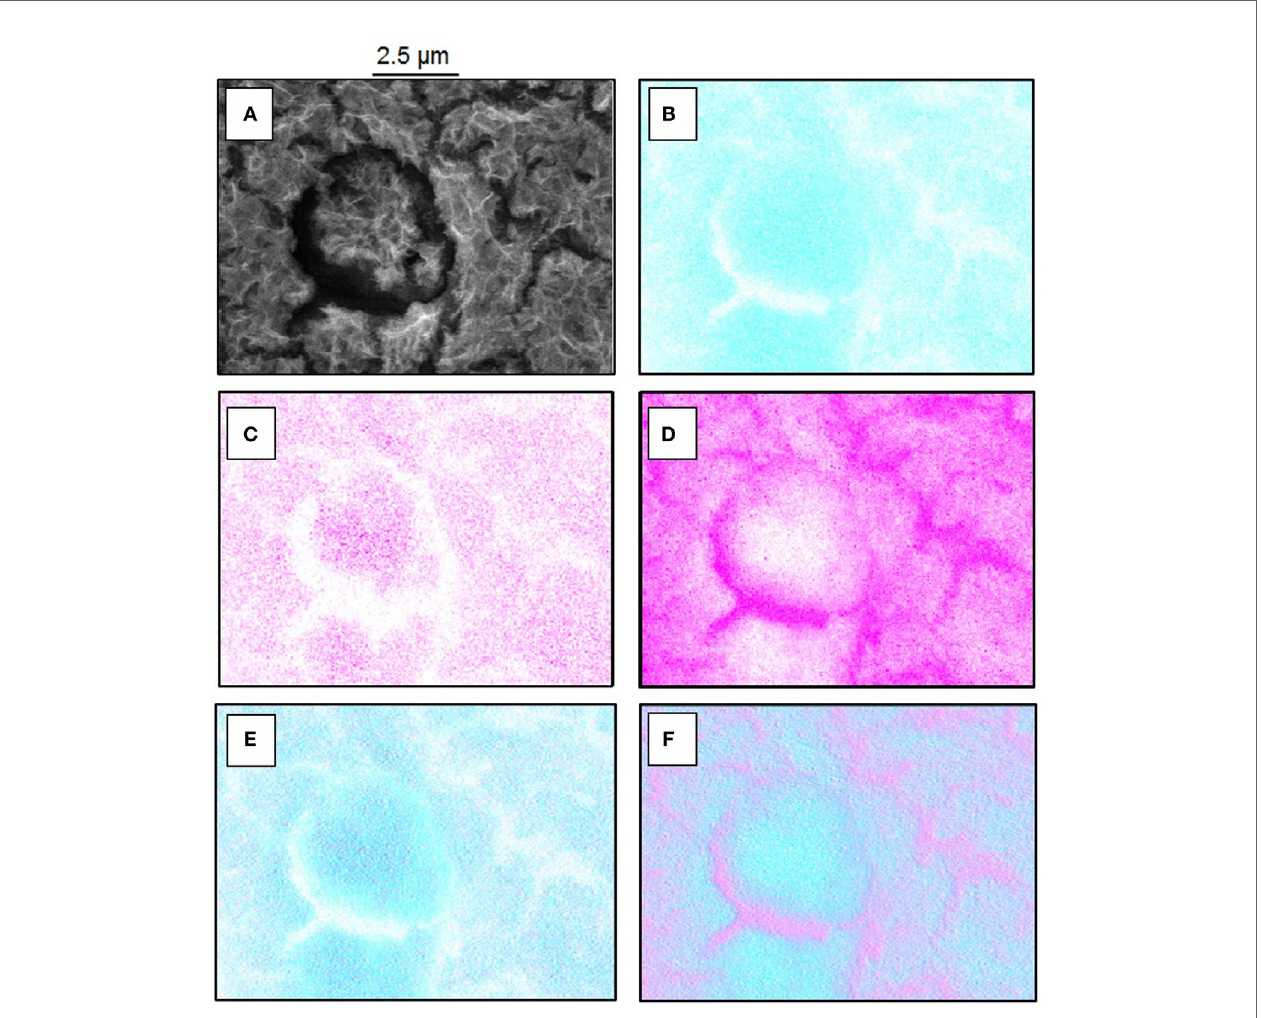
FigUre 2 | (a–F) FE-SEM and EDS mappings of cerium oxide-coated sample. (a) FE-SEM picture for overview, (B) EDS mapping of oxygen, (c) EDS mapping of cerium, (D) EDS mapping of magnesium, (e) overlay of cerium (magenta) and oxygen (cyan blue), and (F) overlay of magnesium (magenta) and oxygen (cyan